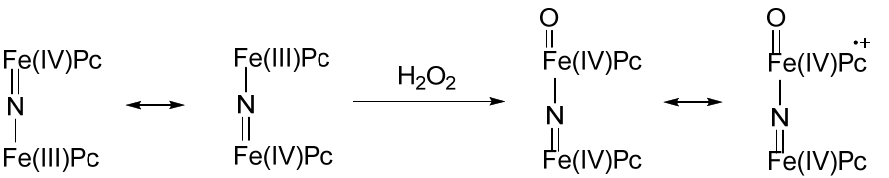
Figure 5. Nitrido-diiron-phthalocyanine with mixed valence state and ultra-high valent peroxo species formed after reaction with oxygen peroxide.